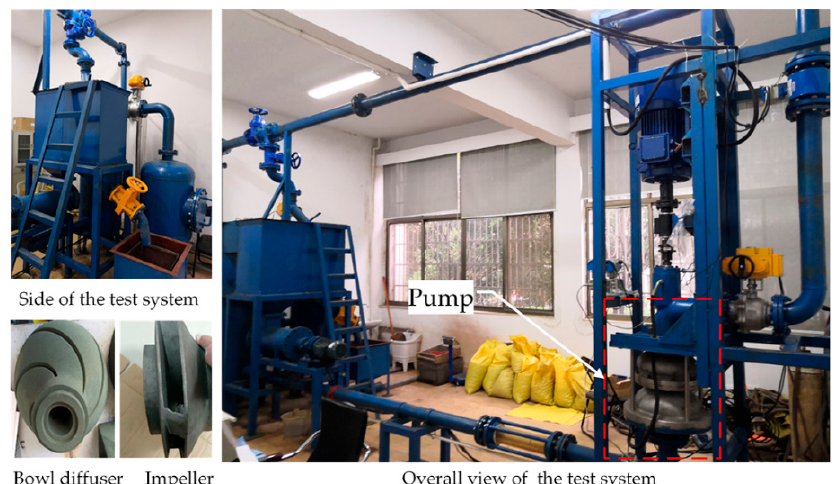
Figure 5. Test system of slurry